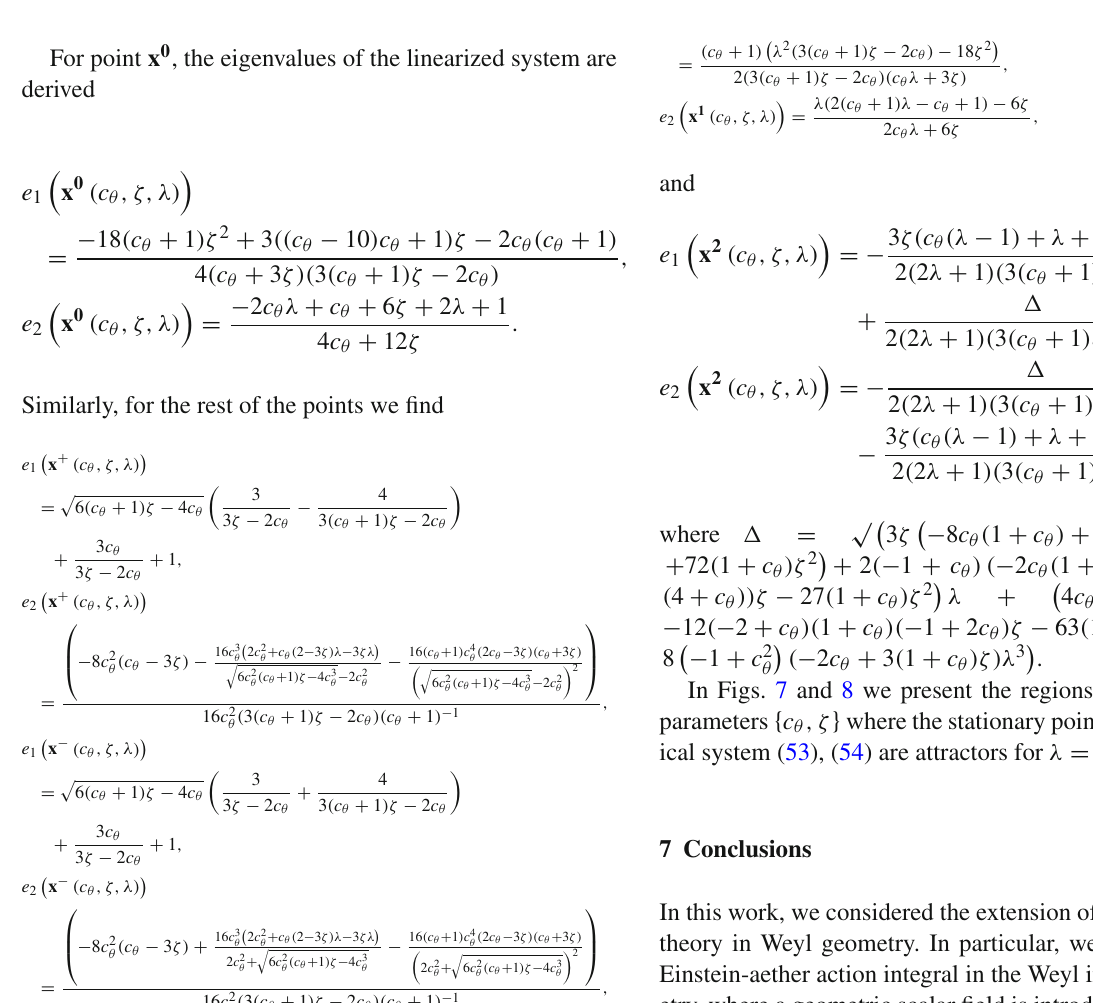
Fig. 6 Region plots in the space of parameters { c θ ,ζ } , where the stationary point x 2 is physically acceptable, for λ = 2 (left fig.) and λ = 0 (right